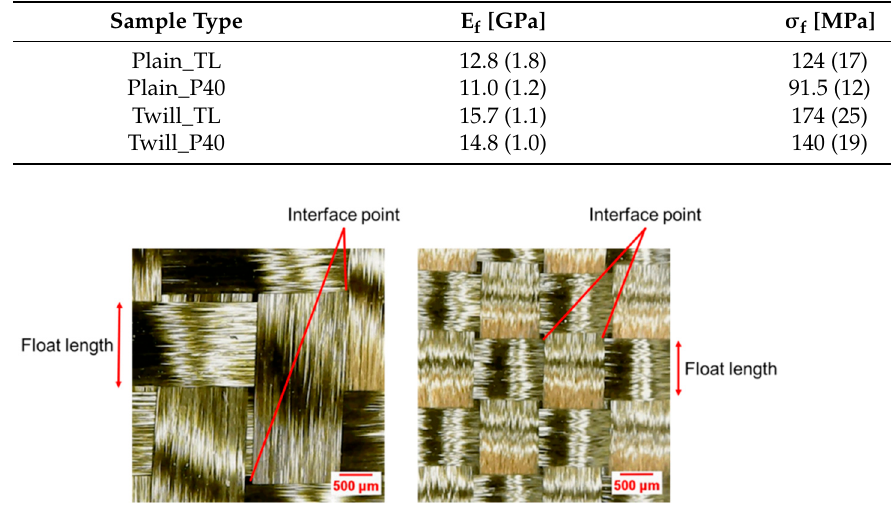
Figure 3. Twill ( left ) and plain ( right ) weave structures.